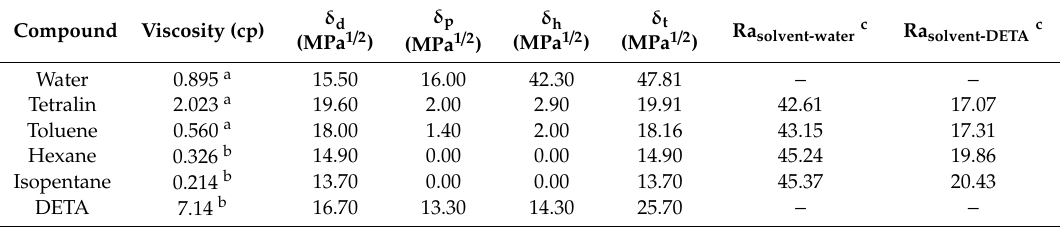
Table 2. Viscosity and Hansen solubility parameters of the